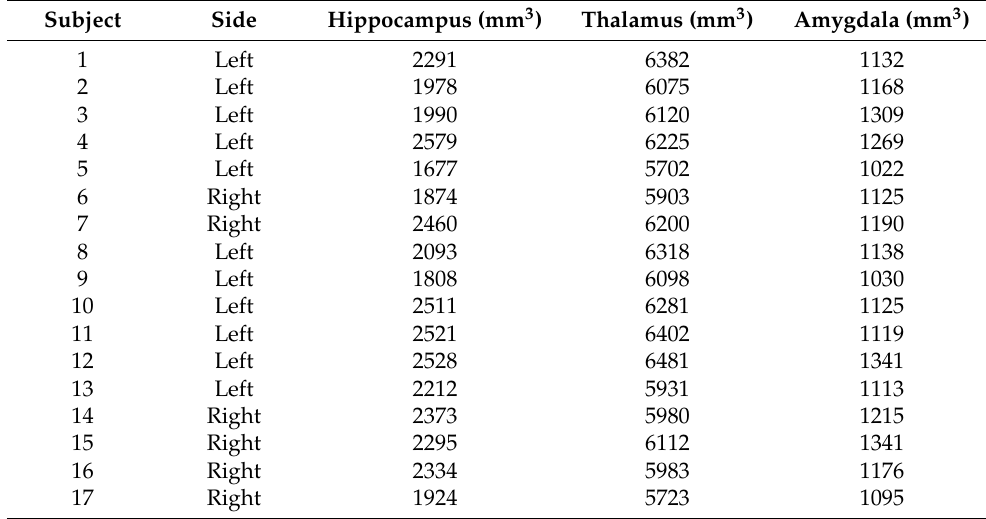
Table 2. Volume of the hippocampus, thalamus, and amygdala in TLE with HS.